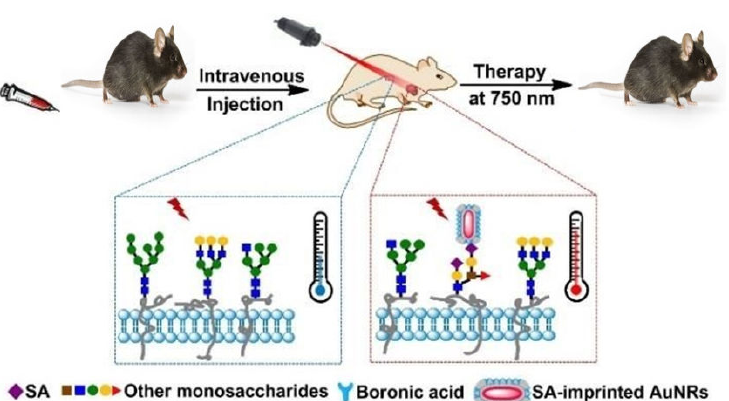
Figure 13. Demonstration of the principle for targeted photothermal therapy through SA-imprinted GNR @SiO 2 [85]. Reprinted with permission from ref. [85]. Copyright 2017